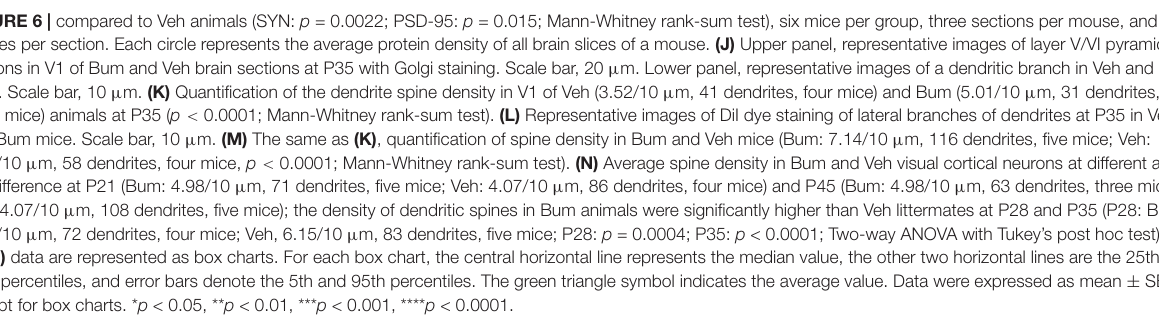
FIGURE 6 | compared to Veh animals (SYN: p = 0.0022; PSD-95: p = 0.015; Mann-Whitney rank-sum test), six mice per group, three sections per mouse, and four images per section. Each circle represents the average protein density of all brain slices of a mouse. (J) Upper panel, representative images of layer V/VI pyramidal neurons in V1 of Bum and Veh brain sections at P35 with Golgi staining. Scale bar, 20 µ m. Lower panel, representative images of a dendritic branch in Veh and Bum mice. Scale bar, 10 µ m. (K) Quantification of the dendrite spine density in V1 of Veh (3.52/10 µ m, 41 dendrites, four mice) and Bum (5.01/10 µ m, 31 dendrites, three mice) animals at P35 ( p < 0.0001; Mann-Whitney rank-sum test). (L) Representative images of DiI dye staining of lateral branches of dendrites at P35 in Veh and Bum mice. Scale bar, 10 µ m. (M) The same as (K) , quantification of spine density in Bum and Veh mice (Bum: 7.14/10 µ m, 116 dendrites, five mice; Veh: 5.14/10 µ m, 58 dendrites, four mice, p < 0.0001; Mann-Whitney rank-sum test). (N) Average spine density in Bum and Veh visual cortical neurons at different ages. No difference at P21 (Bum: 4.98/10 µ m, 71 dendrites, five mice; Veh: 4.07/10 µ m, 86 dendrites, four mice) and P45 (Bum: 4.98/10 µ m, 63 dendrites, three mice; Veh: 4.07/10 µ m, 108 dendrites, five mice); the density of dendritic spines in Bum animals were significantly higher than Veh littermates at P28 and P35 (P28: Bum, 8.12/10 µ m, 72 dendrites, four mice; Veh, 6.15/10 µ m, 83 dendrites, five mice; P28: p = 0.0004; P35: p < 0.0001; Two-way ANOVA with Tukey’s post hoc test).